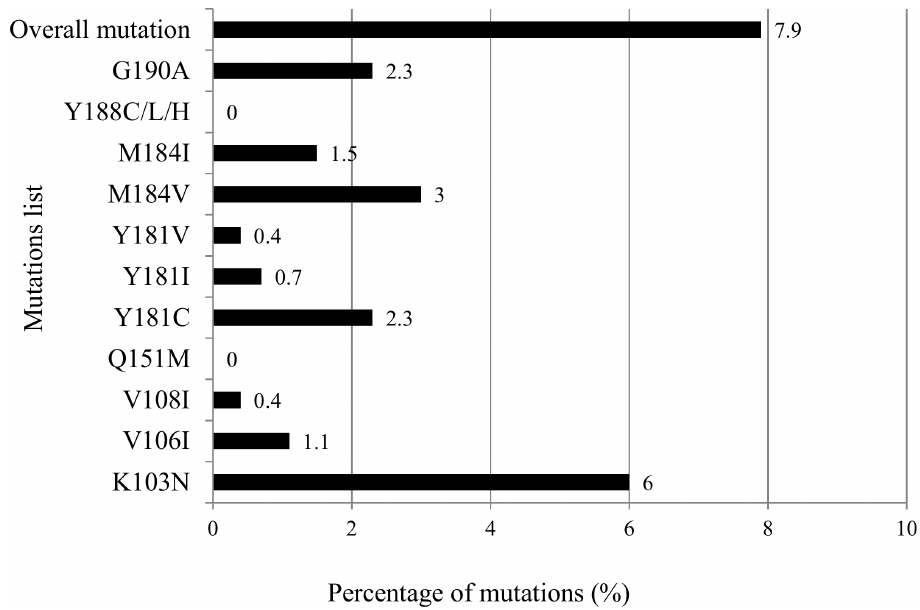
Fig 1. Prevalence of primary HIV drug resistance mutations, from short reverse transcriptase genotypic resistance assay.